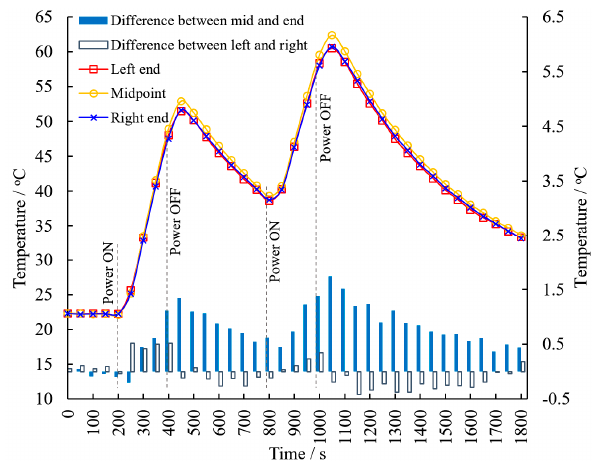
Figure 8. Temperature distribution along axial direction on the surface.